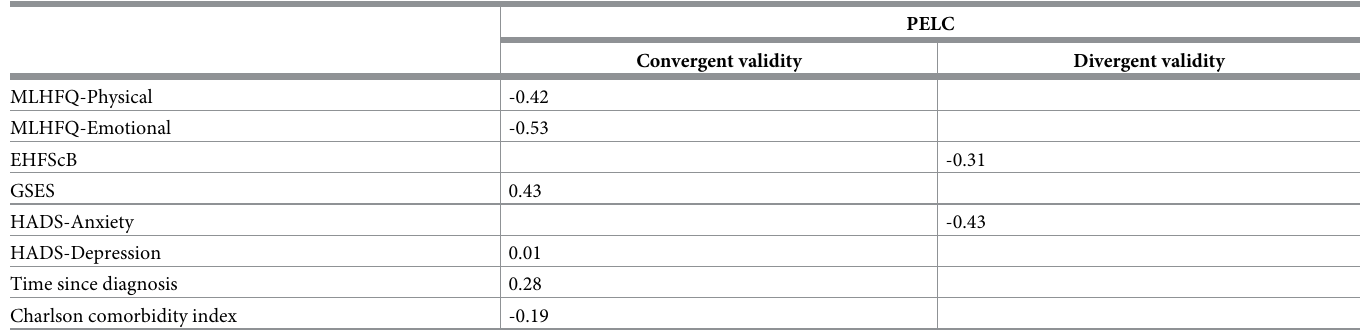
Table 4. Multifeature-multimethod Pearson correlation matrix evaluating the PELC questionnaire validity (n =